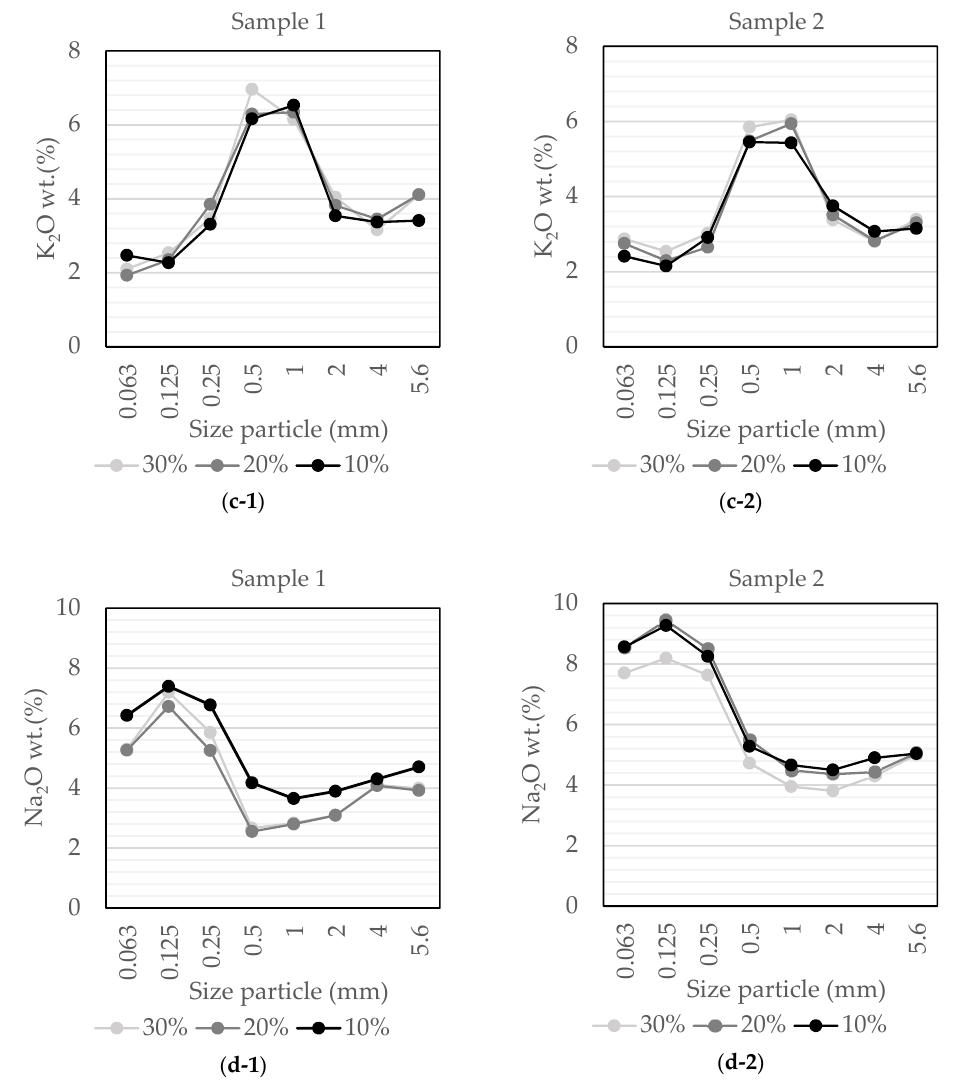
Figure 5. Representative composition of the Penouta ore after compression breakage for: ( a ) silica oxide; ( b ) aluminum oxide; ( c ) potassium oxide and ( d ) sodium oxide, for sample 1 and sample 2. Table 3. Niobium (Nb), tin (Sn) and tantalum (Ta) content in different size fractions of the Penouta ore after compression breakage at compression ratios of 30%, 20% and 10% for samples 1 and 2.